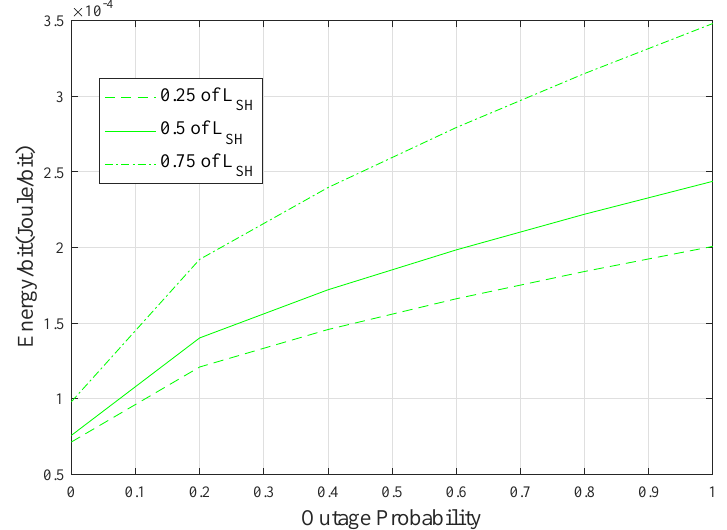
Figure 11. Energy consumption of the SDF system with respect to outage